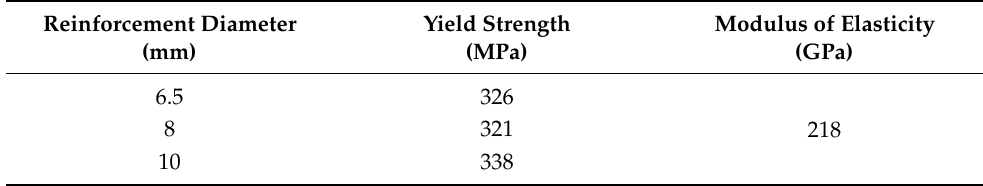
Table 1. The basic properties of HPB300.